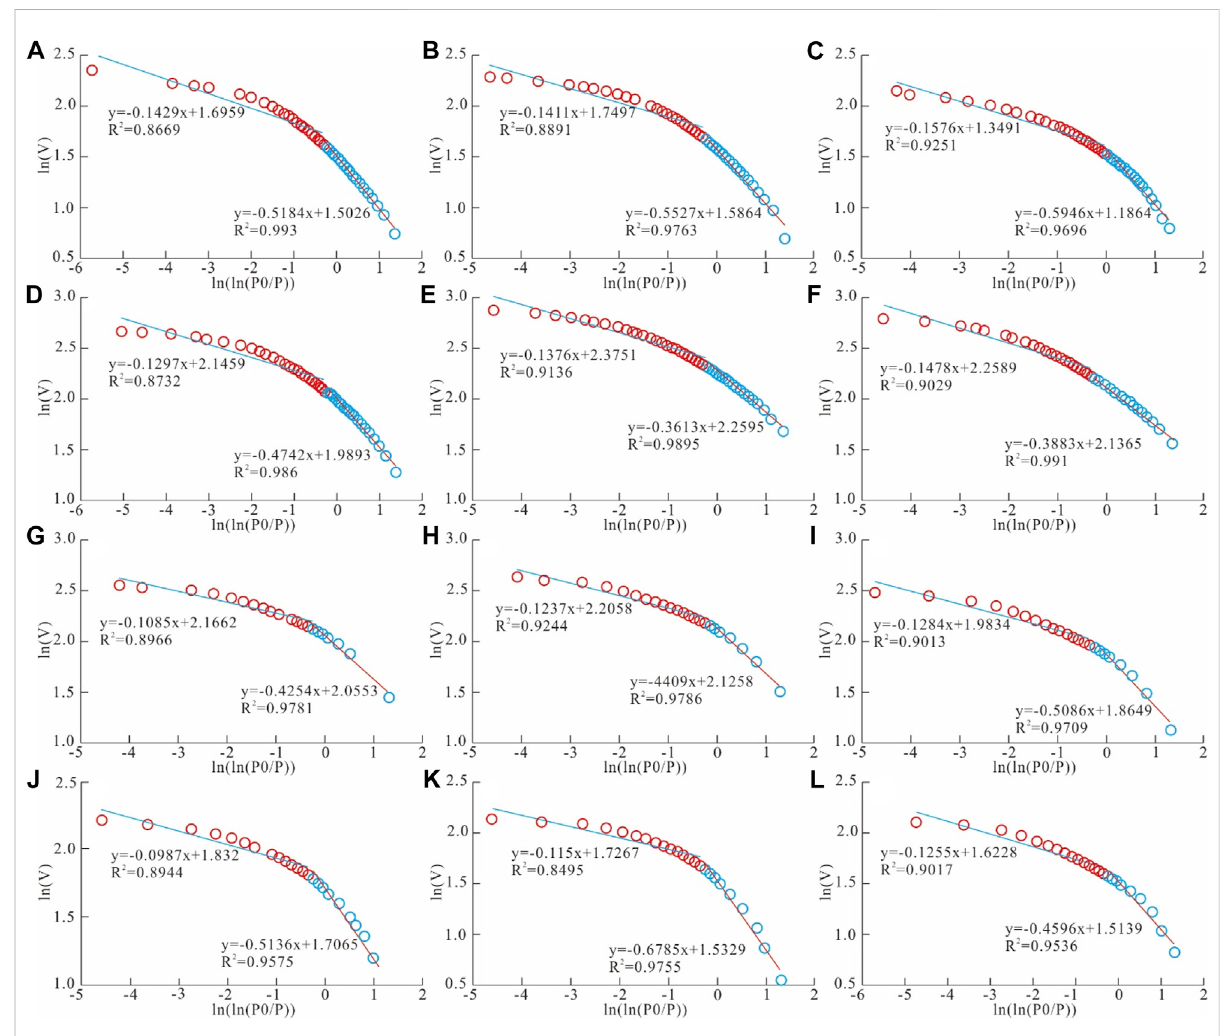
FIGURE 4 ln (V) vs ln [ln (P 0 /P)] curves of the Longmaxi Formation shale in the Changning area. (A – F) is from ZK 1, and (G – L) is from ZK 2